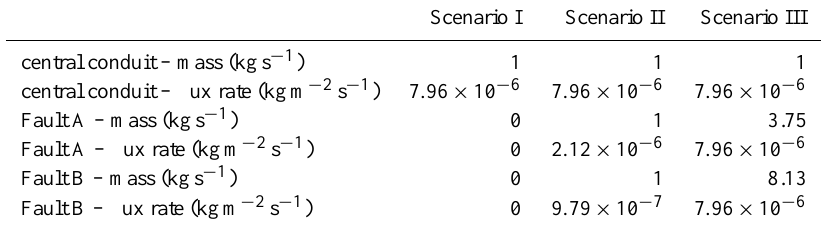
Table 3. Different injection values (mass and flux rate) for the central conduit and faults, normalised to the injection of a mass of 1kg of fluids. Base area of the central conduit is π × 200 2 = 125664m 2 , of the Fault A core zone is 2 π × 3000 × 25 = 471239m 2 , of the Fault B core zone is 2 π × 6500 × 25 = 1021018m 2